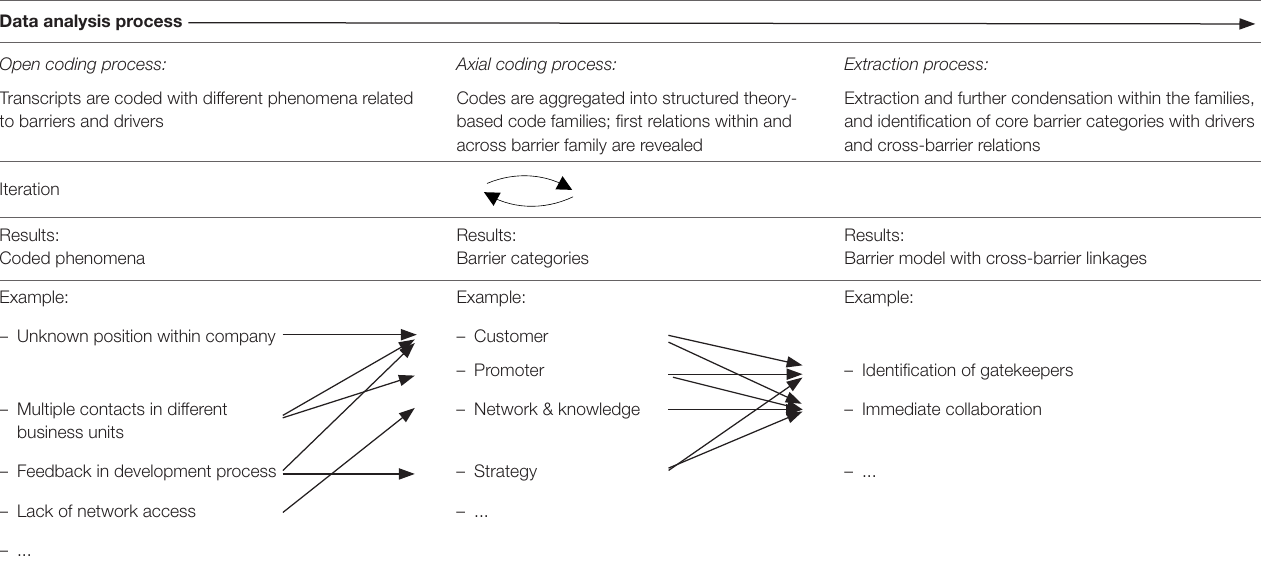
TaBle 1 | Exemplary overview of the data analysis process (adapted from Hahn and Ince, 2016). Data analysis